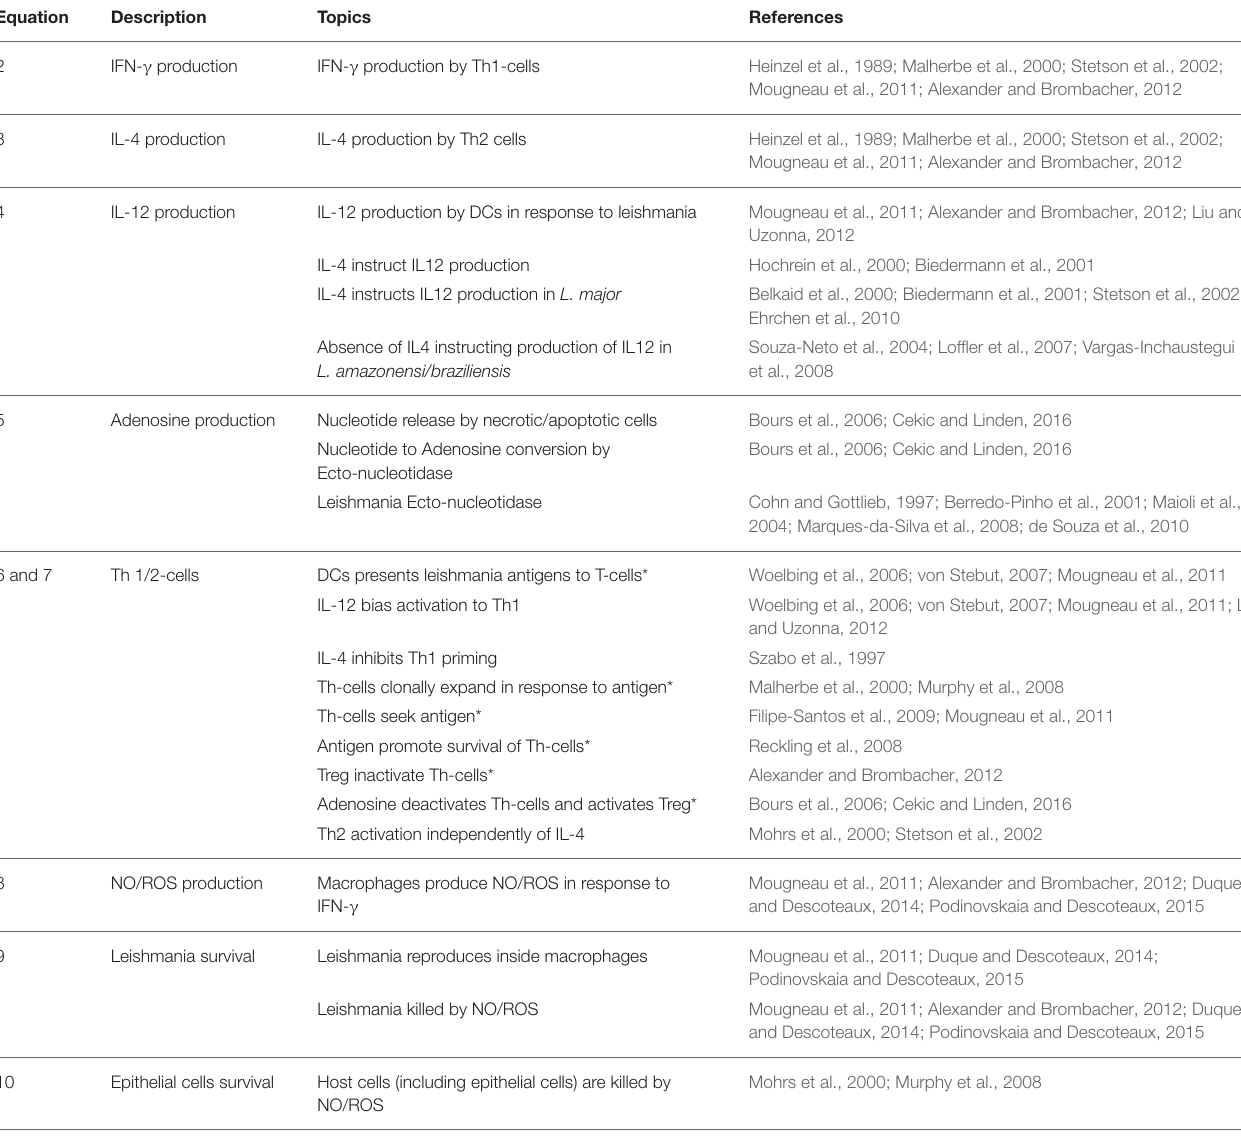
TABLE 1 | Rationale for Equations (2)–(10): references reporting experimental evidences for the parameters used in the model.